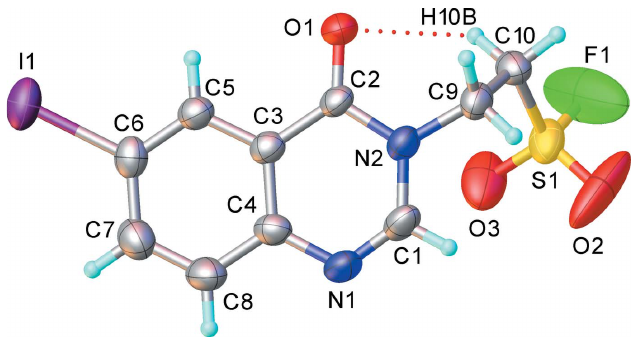
Figure 1 Molecular structure of (I). The atomic displacement ellipsoids are drawn at the 50% probability